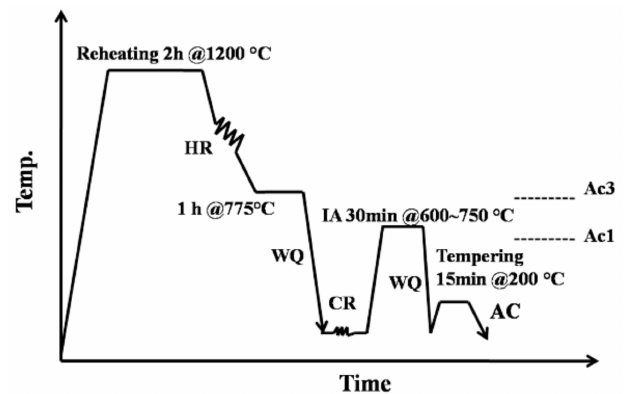
Figure 2. Schematic of the thermo-mechanical treatment for the experimental steel,